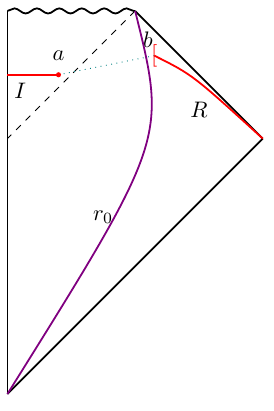
Figure 2 . Entanglement regions in the radiation part with the assumption that there is an island inside the black hole. The fictitious boundary shown by violet lines at r = r 0 specifies the region over which the gravity is negligible, i.e. the radiation